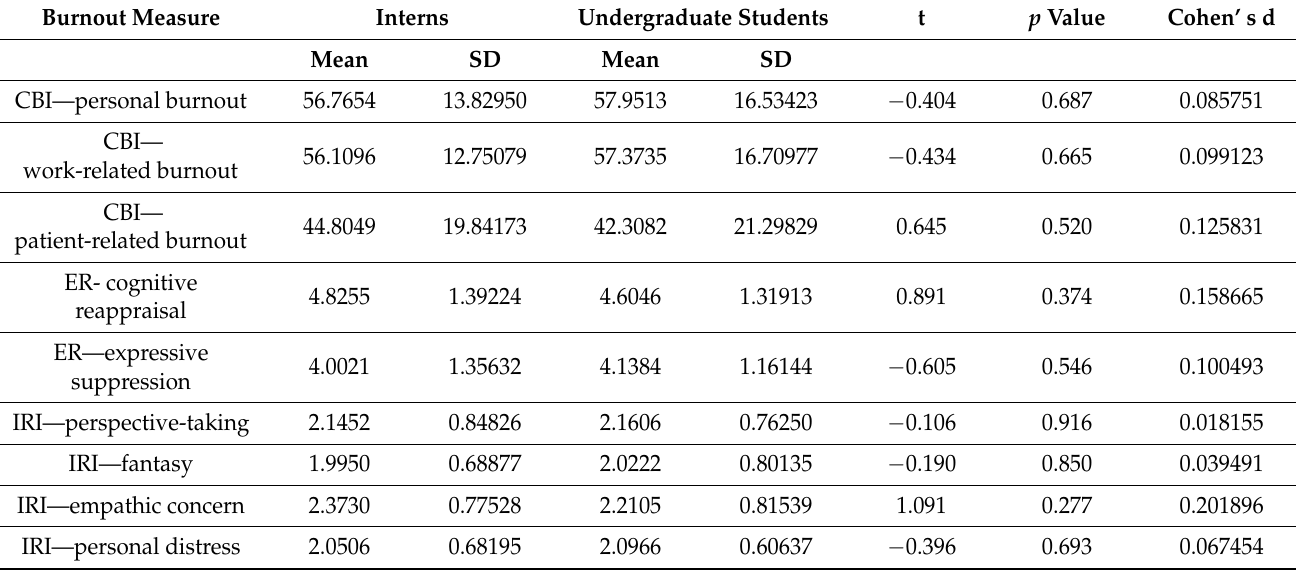
Table 1. Comparison of burnout, emotional regulation, and social cognitive scores among interns and undergraduate dental